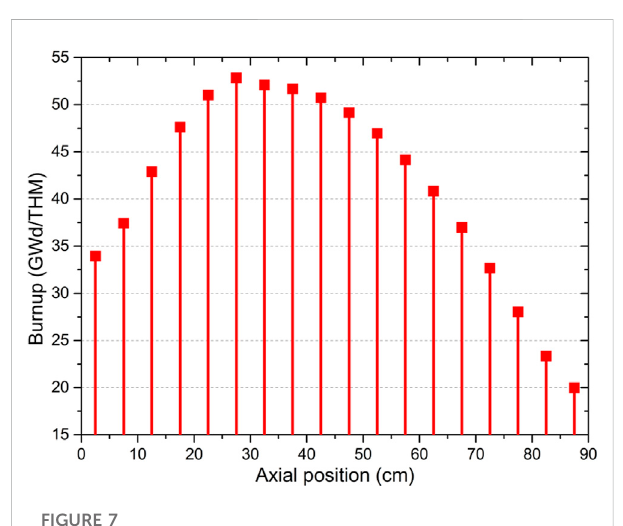
FIGURE 7 Burnup per small zones for scenario 2 at the EOC.